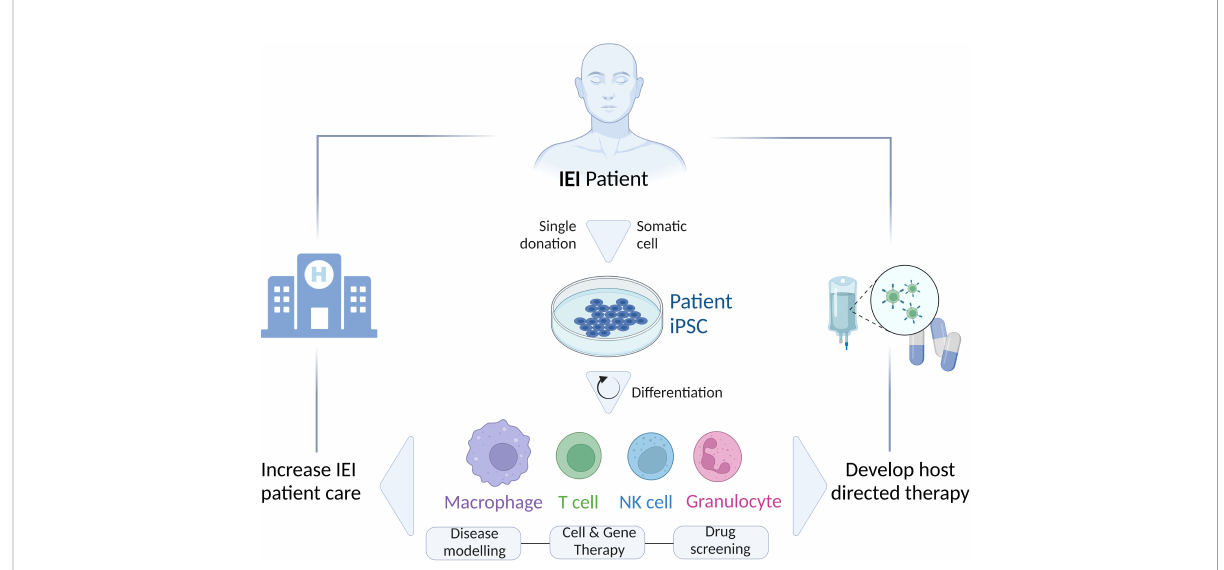
FIGURE 1 Schematic representation of the generation and differentiation of patient ’ s-speci fi c iPSCs to different cell types (Macrophages, T cells, NK cells, Granulocytes) for various applications (Disease modeling; Cell and Gene therapy; Drug screening) to study IEI and improve the patient ’ s care by developing novel host directed therapies. IEI, inborn errors of immunity; iPSC, induced-pluripotent stem